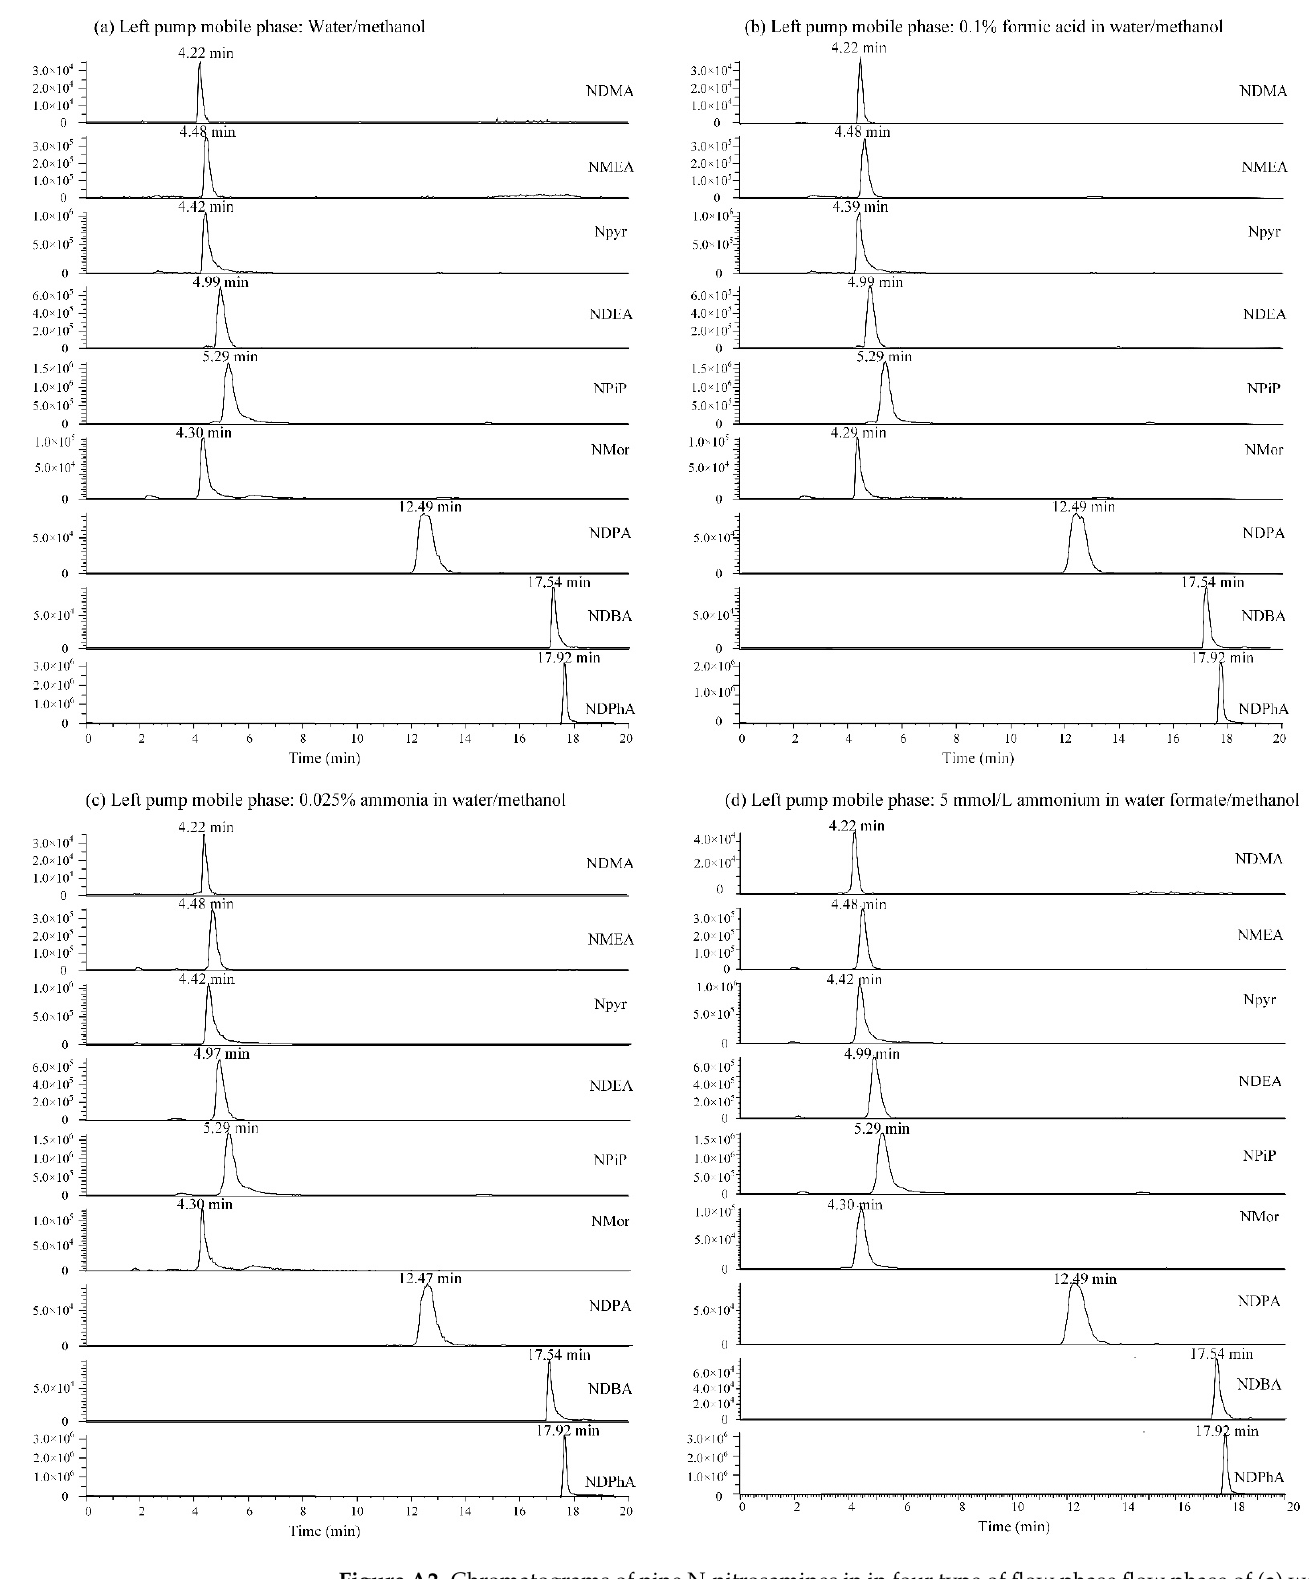
Figure A2. Chromatograms of nine N-nitrosamines in in four type of flow phase flow phase of ( a ) water/methanol, ( b ) 0.1% formic acid in water/acetonitrile, ( c ) 0.025% ammonia in water/methanol, and ( d ) 5 mmol/L ammonium formate in water/methanol.